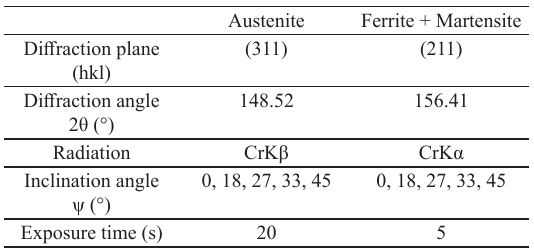
Table 2. Parameters used for the X-ray residual stresses